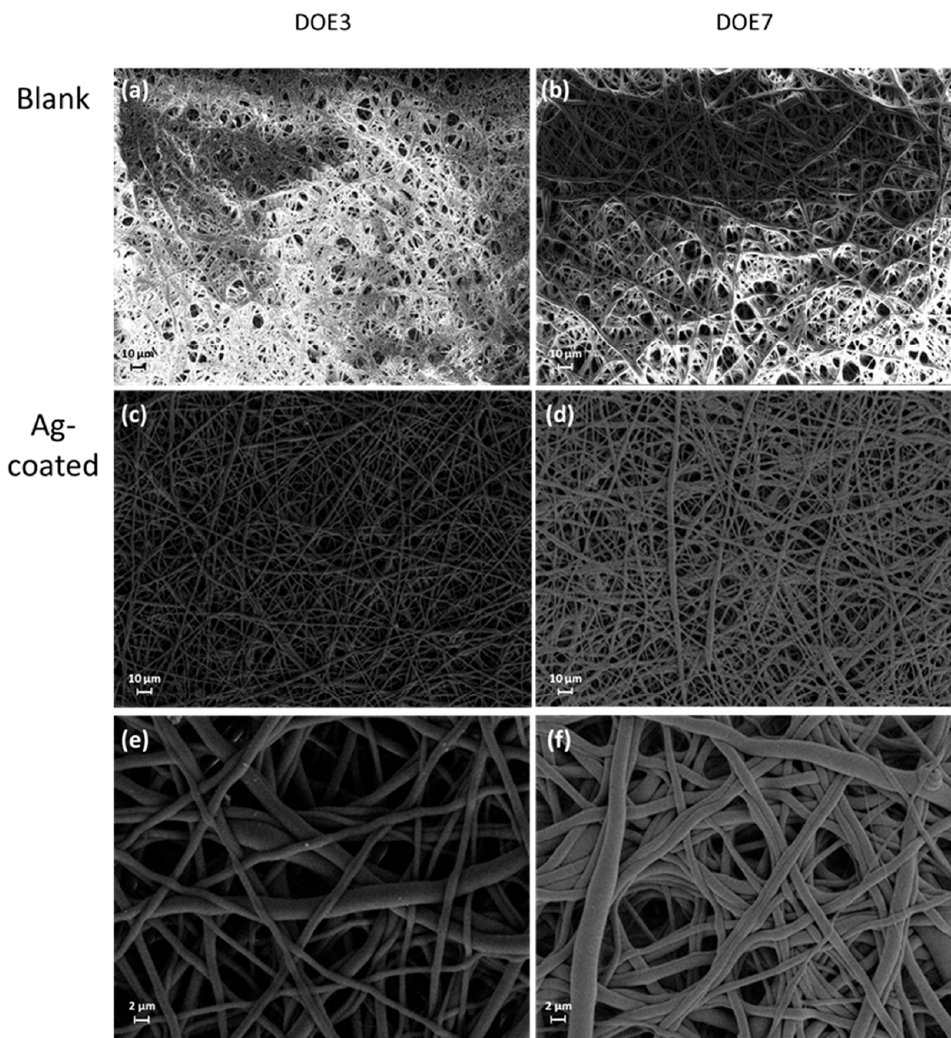
Figure 5. SEM micrographs at different magnification (from 500 × to 5000 × ) of bare samples ( a , b ) and Ag-coated ones ( c – f